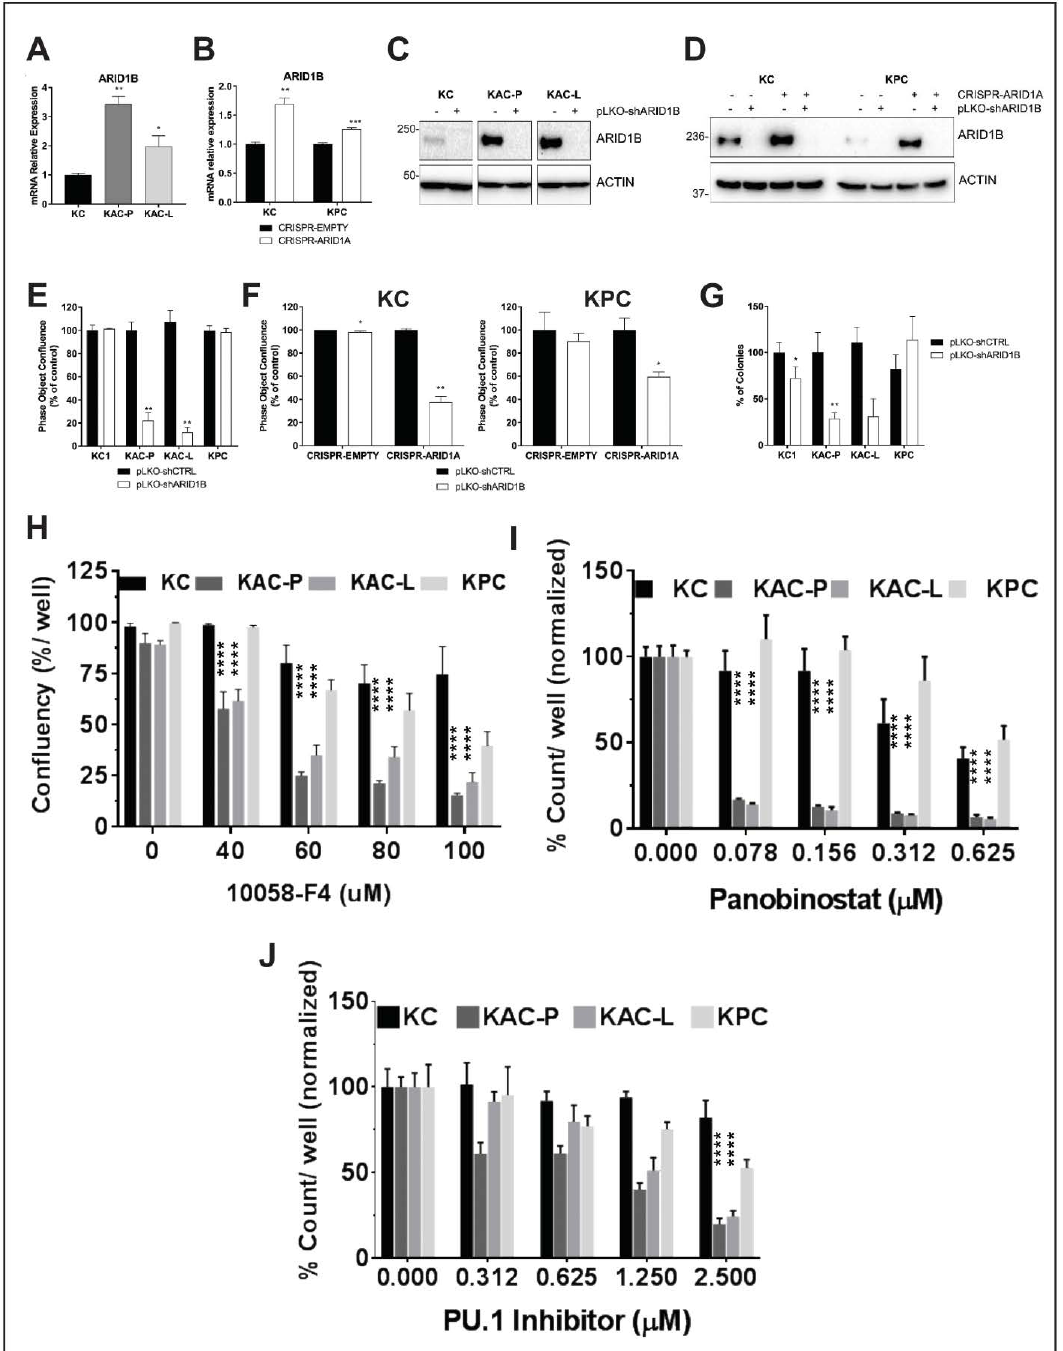
Figure 7. Identification of synthetic lethality in autochthonous Arid1a -null PDAC cells. ( A , B ) Semi-quantitative RT 2 PCR revealed higher Arid1b mRNA expression in Arid1a -deleted autochthonous ( A ) and isogenic ( B ) cell lines, compared to “KC” or CRISPR-EMPTY control cells, respectively. ( C , D ) Immunoblotting for ARID1B confirmed loss of protein expression in Arid1a -deleted autochthonous ( C ) and isogenic ( D ) cell lines after Arid1b knockdown using pLKO-shRNA. Detailed information can be found at Figure S13. ( E , F ) In vitro monolayer cultures of autochthonous ( E ) and isogenic “KC” and “KPC” ( F ) cell lines upon knockdown of Arid1b, showed significant reduction in proliferation, expressed as % of pLKO-shCTRL-transduced cells. ( G ) Anchorage-independent colony growth assay on soft-agar showed significant reduction in number of colonies upon